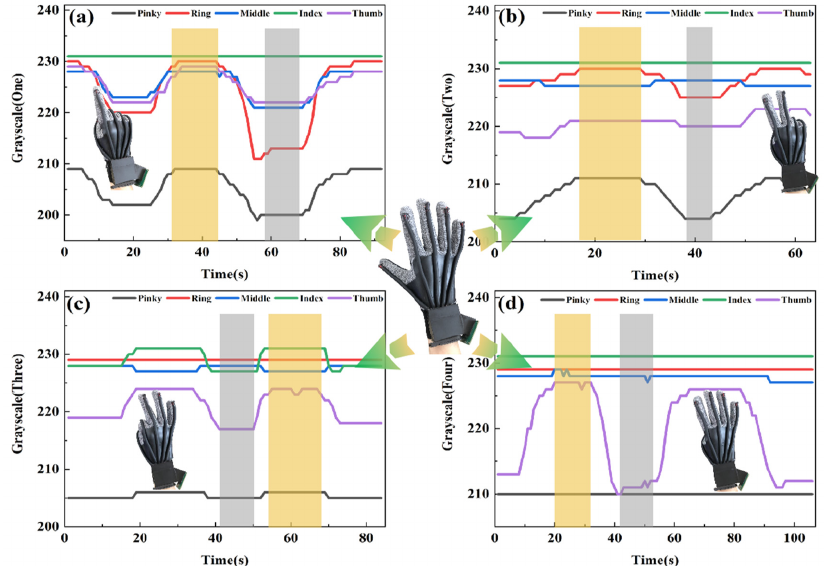
Figure 7. The quantization process of finger bending of data glove and intuitive observation of gesture capture process. The data glove from the stretch state repeatedly makes the ( a ) Number 1, ( b ) Number 2, ( c ) Number 3 and ( d ) Number 4 gestures from the stretch state. The yellow area represents the data block of the five-finger stretch state, and the gray area represents the data block of the corresponding gesture.